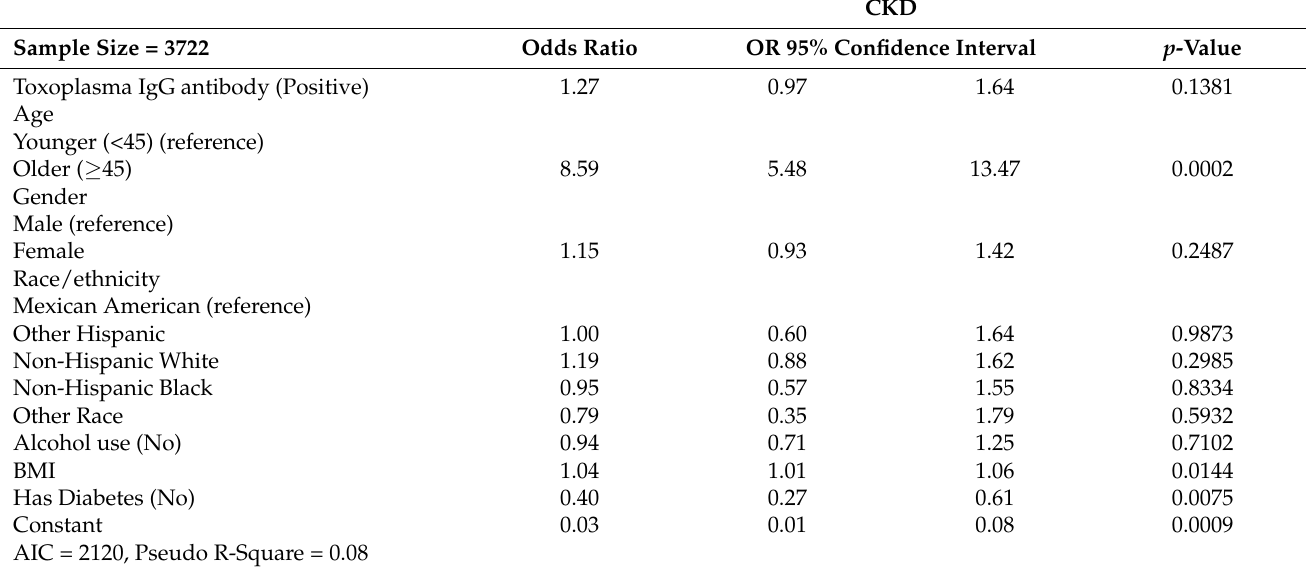
Table 5. Binomial Logistic regression model for CKD status on T. gondii IgG antibody (posi- tive/negative) adjusted for the demographic factors and other